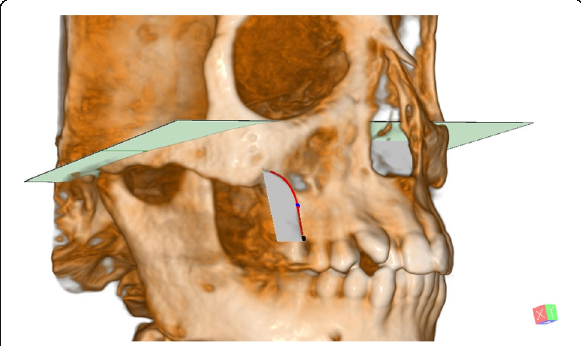
Fig. 3 Maxillary basal bone. Red curve shows cut at Mid-Max.